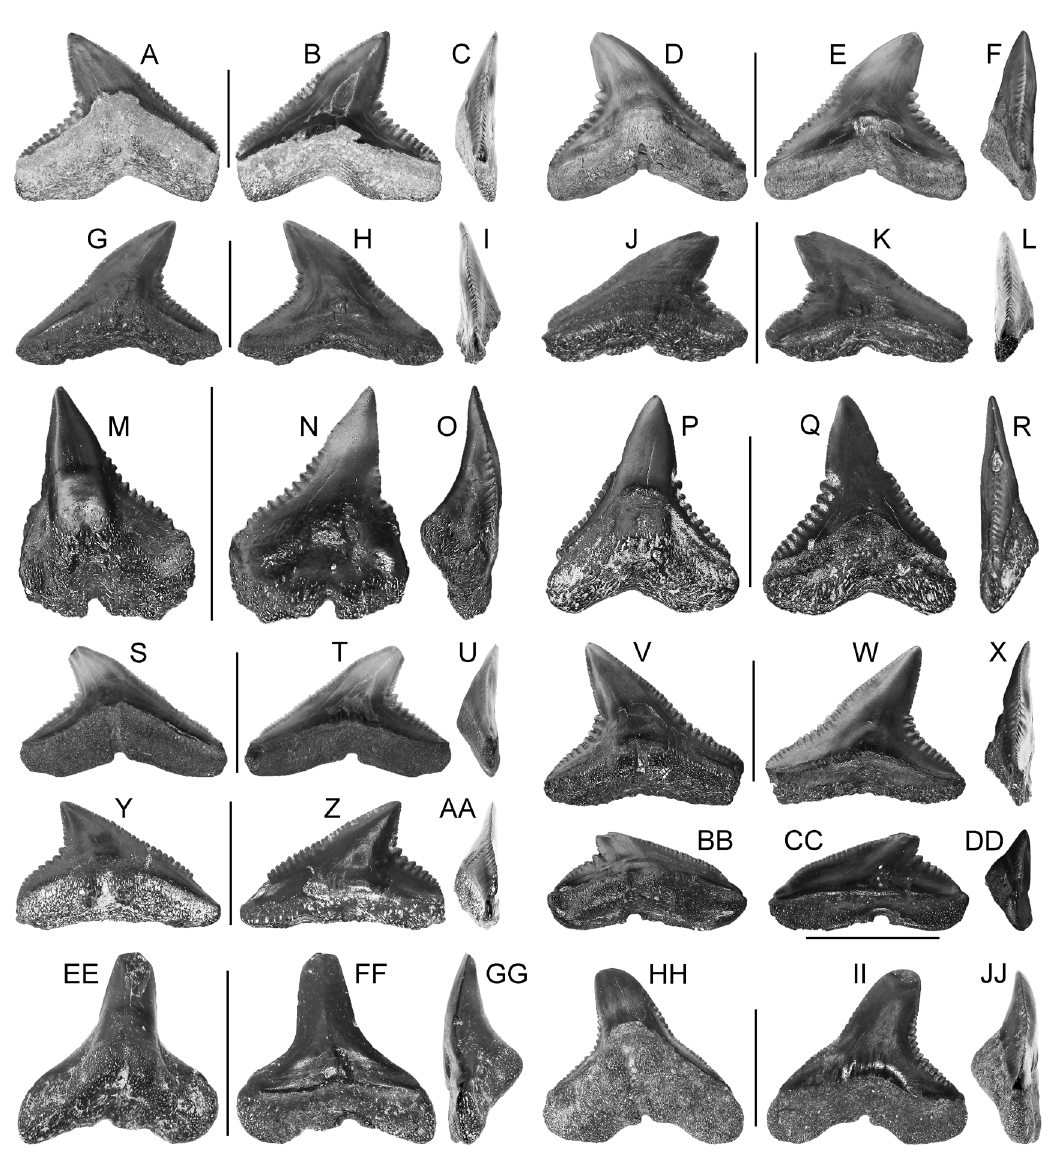
Fig. 26. Carcharhinus mancinae sp. nov. referred specimens. A–C . MSC 38426.16, upper lateral